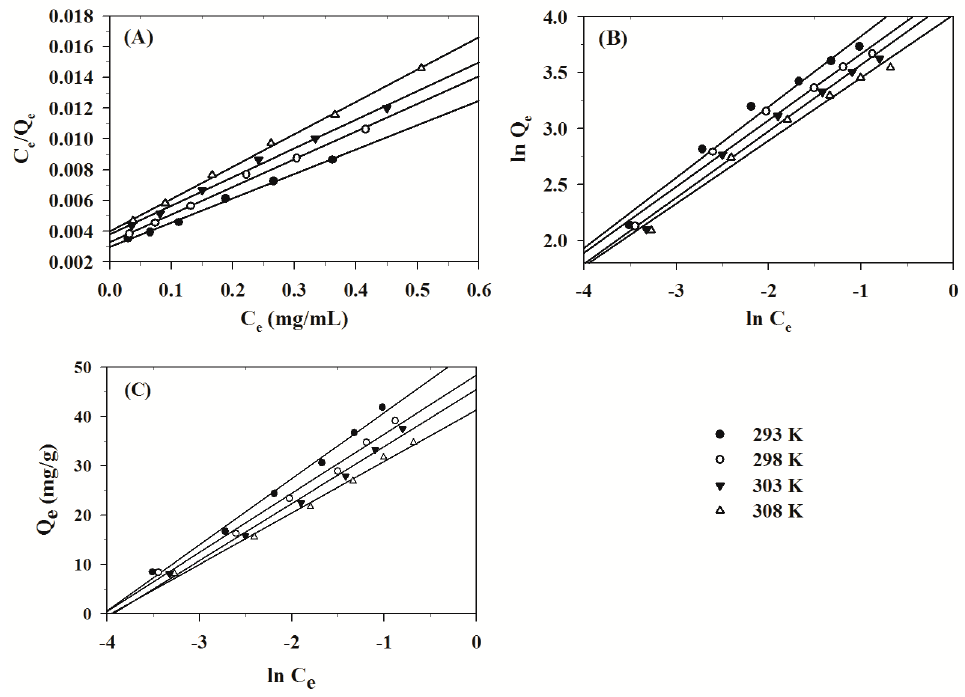
Figure 3. Langmuir adsorption isotherm ( A ), Freundlich adsorption isotherm ( B ) and Tempkin adsorption isotherm ( C ) for the adsorption of TPS onto MPS (MPS dose = 1.0 g/50 mL, pH = 6.7, Adsorption time = 120 min, Initial conc. = 0.2–1.2 mg/mL, Temp. = 293–308 K).